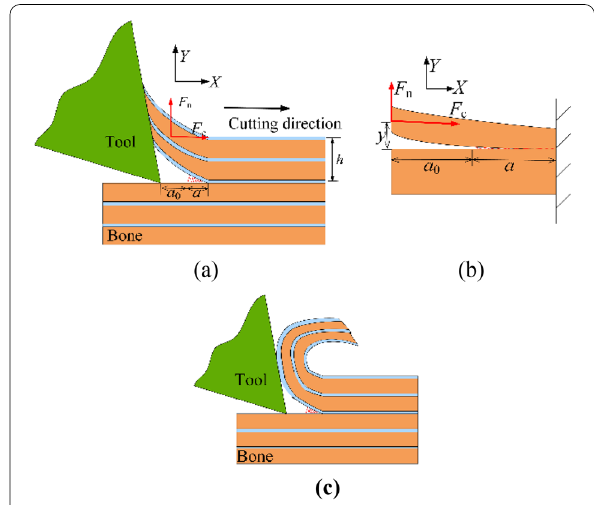
Figure 2 Mode #1: a Cutting model, b Cutting force on bone osteon and c Predicted chip